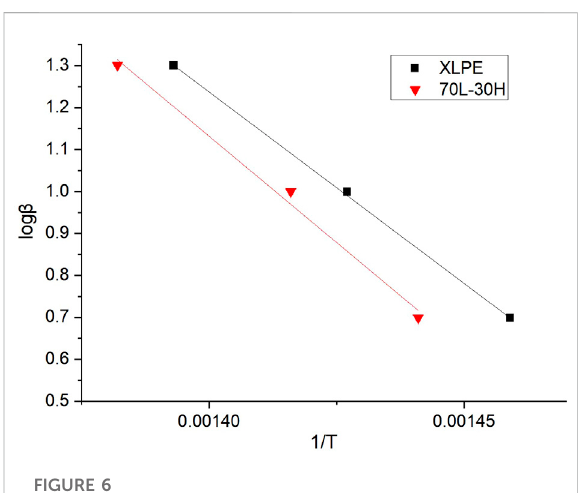
FIGURE 6 Fitting line between log β and 1/T of 70L – 30H and